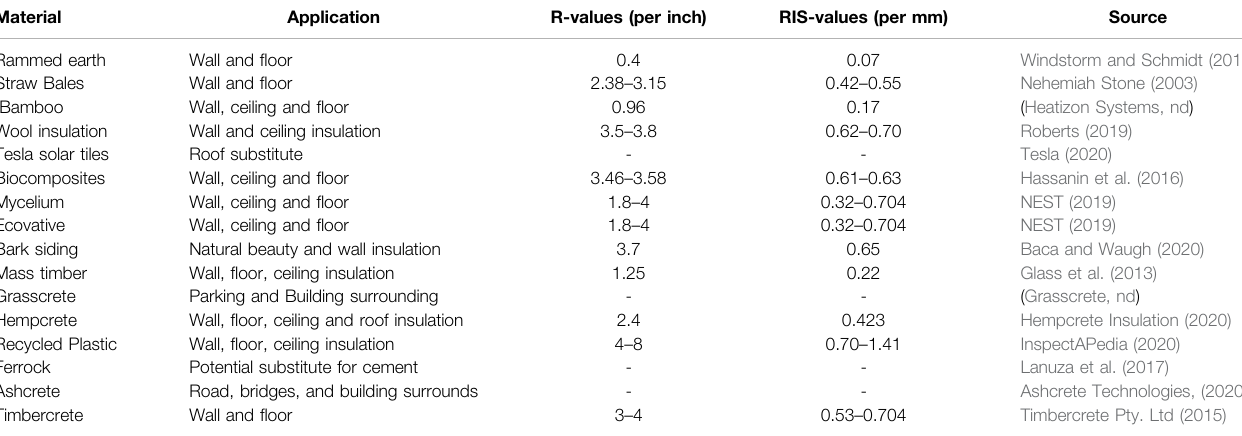
TABLE 4 | Alternative building materials.